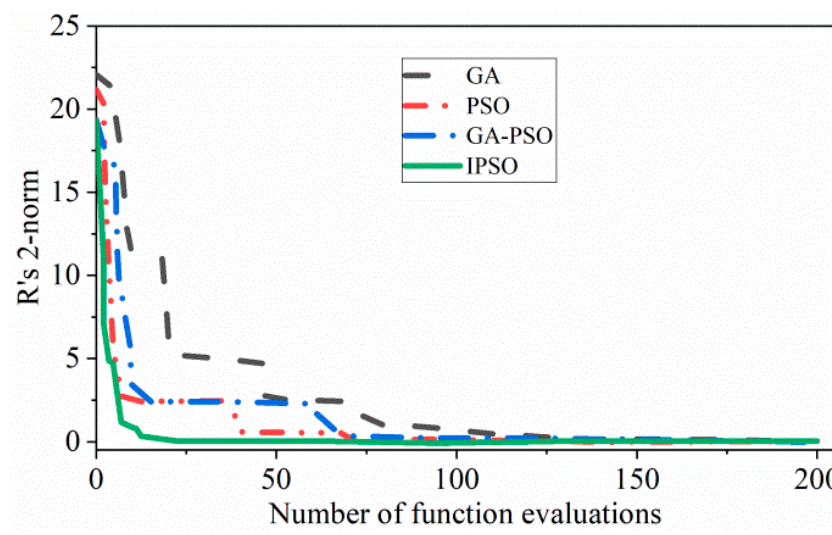
Figure 2. Comparison of the four methods’ convergence rates.